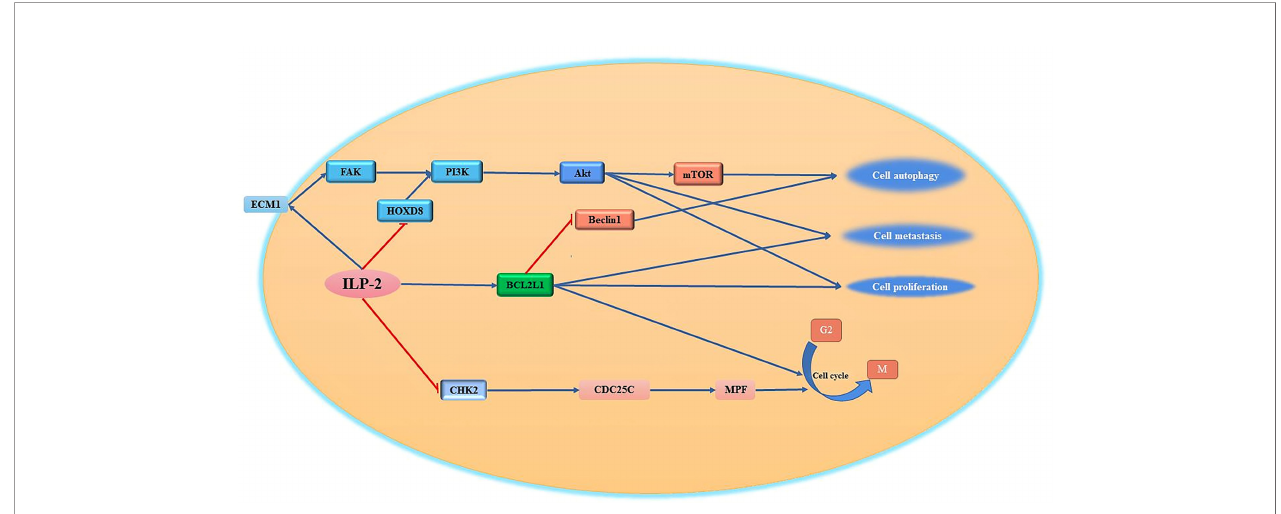
FIGURE 4 | Regulation of cell proliferation, migration and cell cycle by ILP-2. ILP-2 activates Bcl-2, ECM1-Akt signaling pathway, inhibits CHK2 expression and promotes cell proliferation, autophagy, migration as well as cell cycle